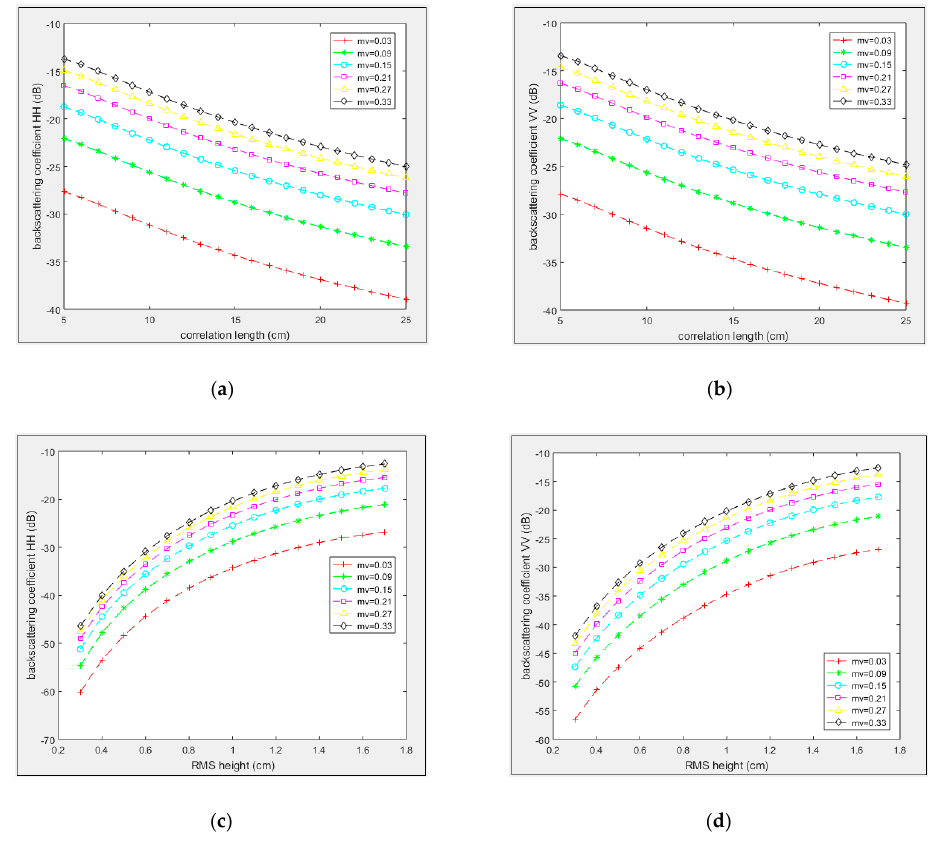
Figure 9. Responses of the roughness parameters and soil backscattering coefficient: ( a )( c ) HH polarization; ( b )( d ) VV polarization.